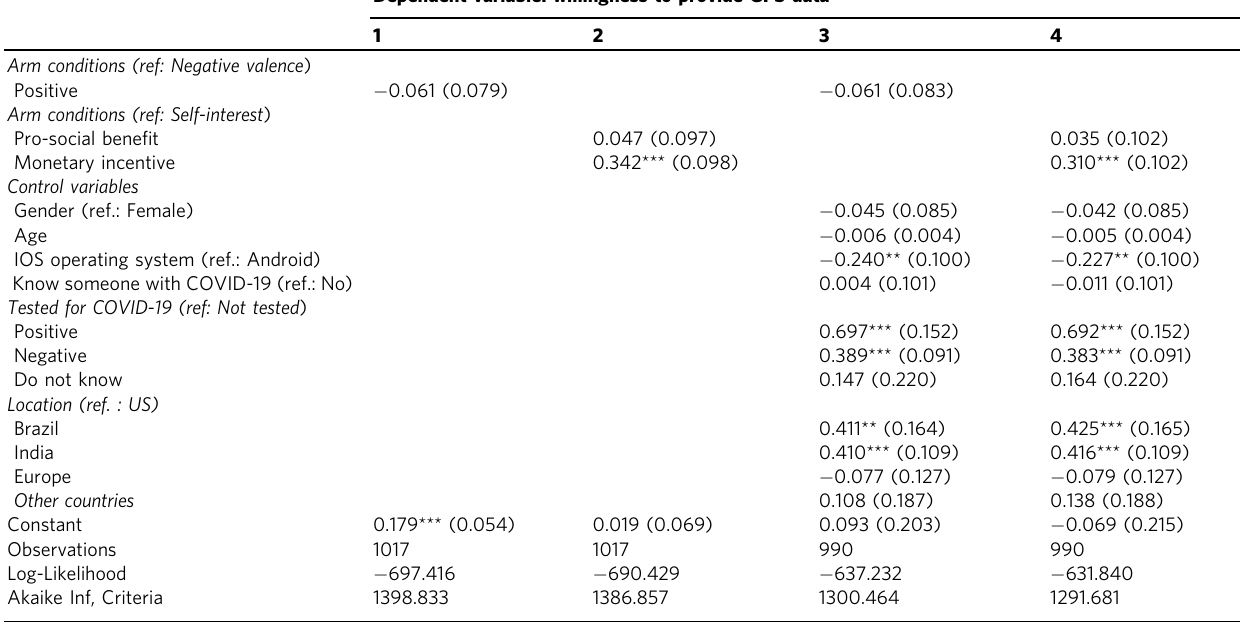
Table 2 Determinants of the willingness to provide GPS data.